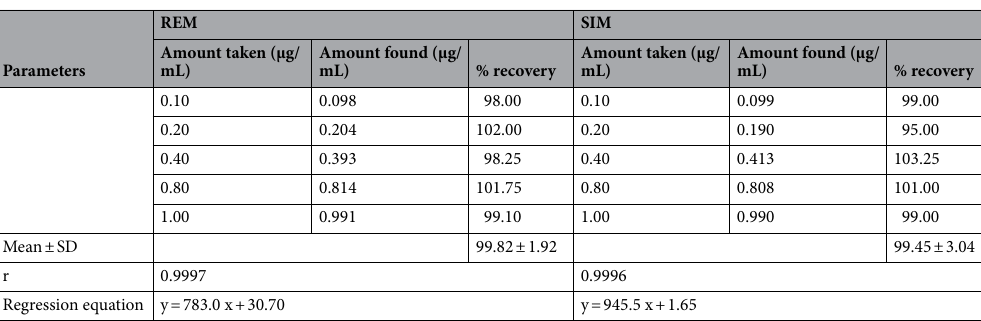
Table 5. Application of the proposed spectrofluorimetric method for the determination of the studied drugs in spiked human plasma.